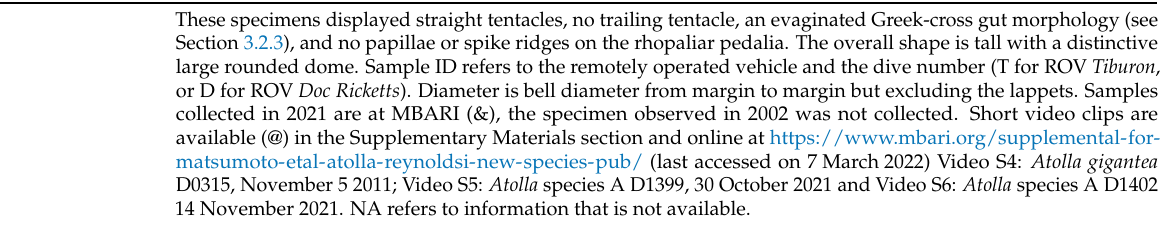
Table 4. Physical measurements and water parameters for the collected specimens of Atolla species